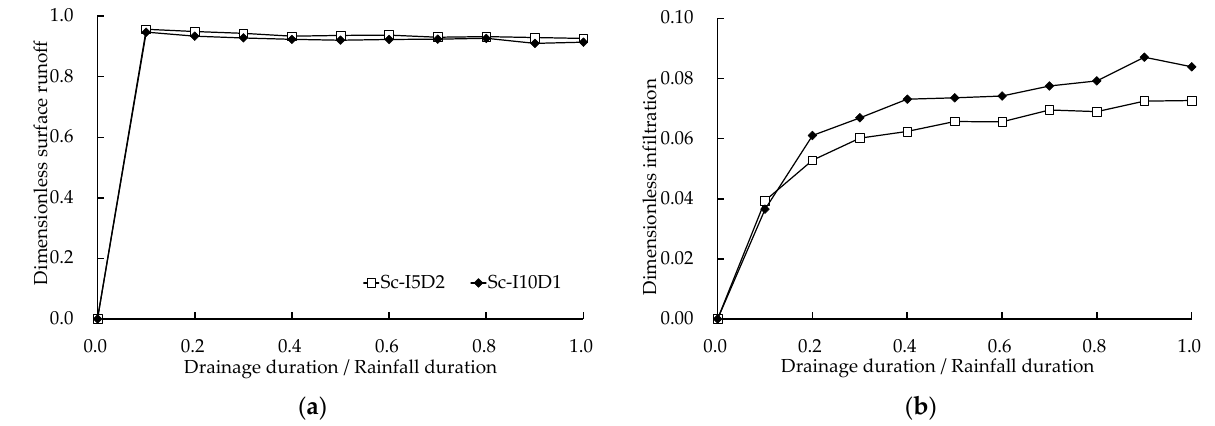
( b ) Figure 12. Results of scaled model simulation for 600 s: ( a ) surface runoff; ( b ) infiltration.